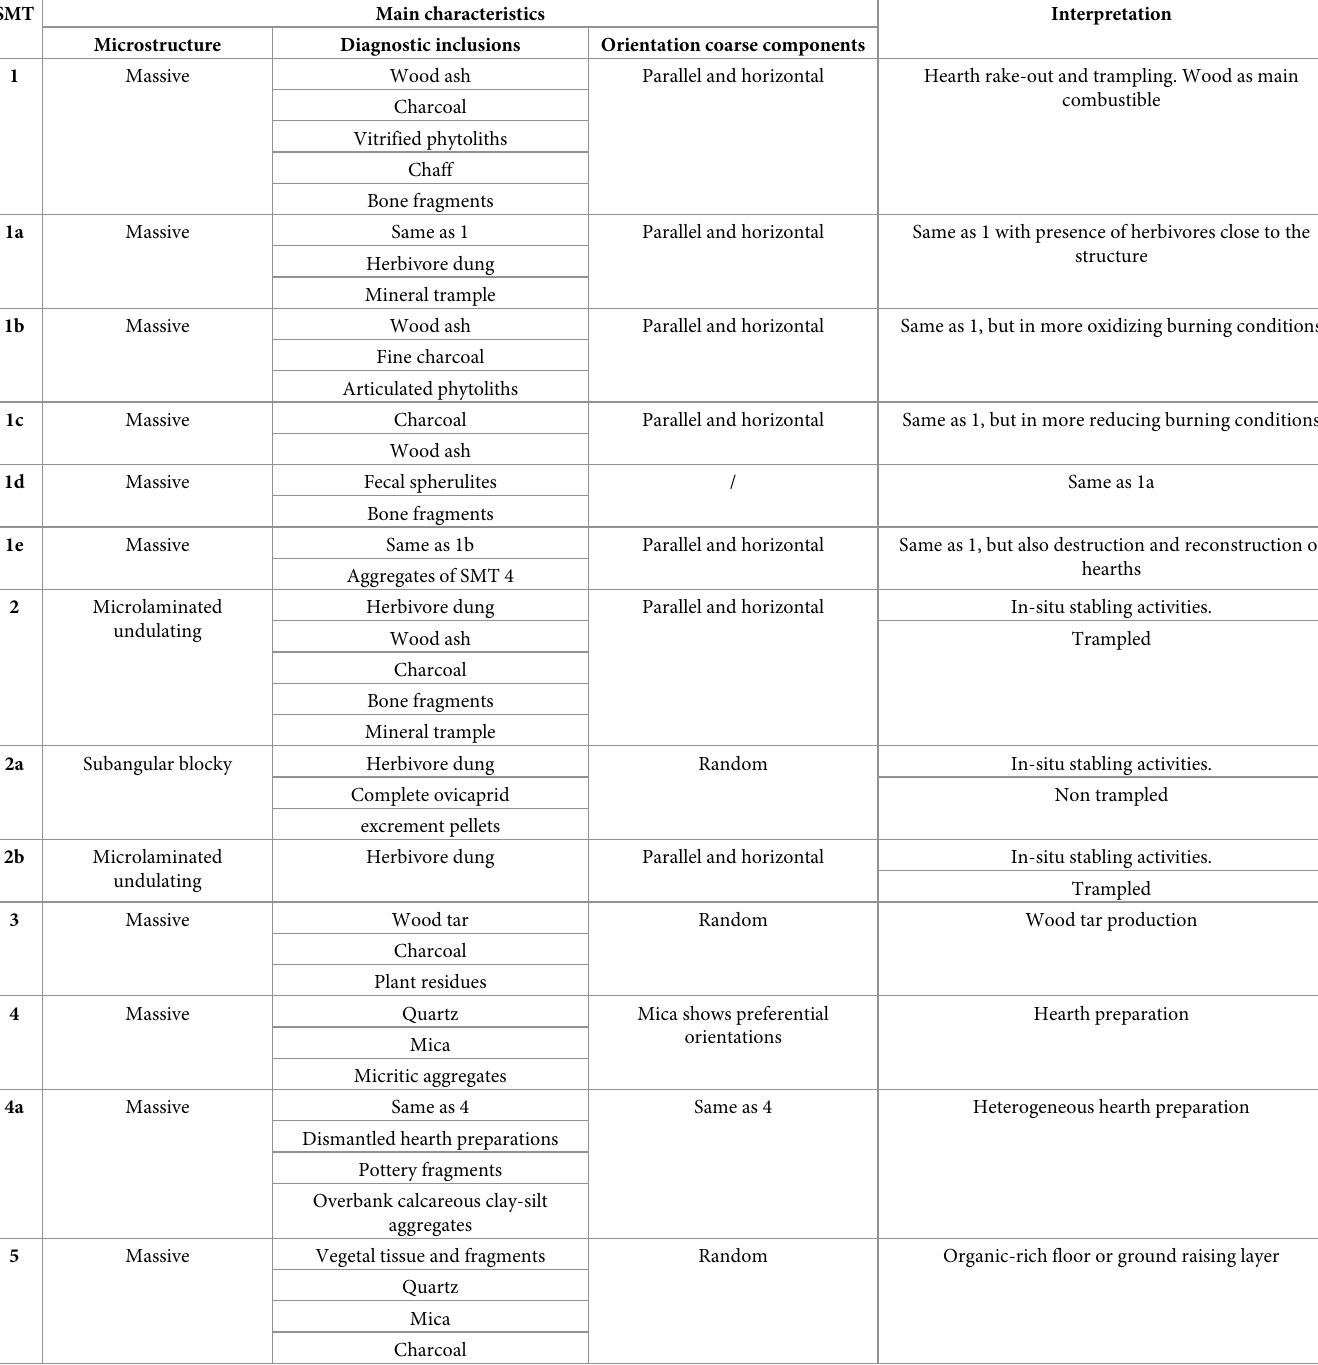
Table 1. Table reporting the main characteristics (microstructure, diagnostic inclusions, orientation of the coarse components) and interpretation of each SMT and subtype.